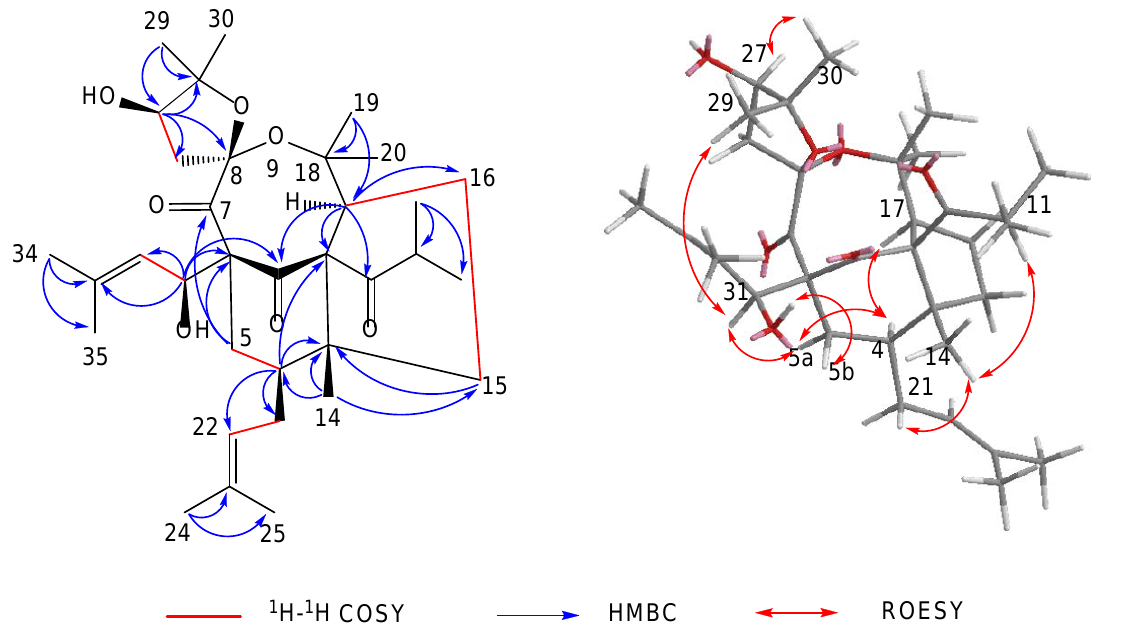
Figure 2. Key 2D NMR correlations of hyperacmosin R ( 1 ).